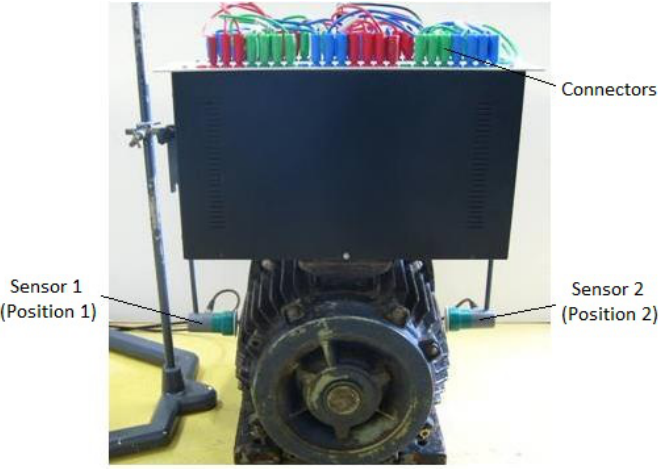
Figure 7. Salient synchronous modified machine and the sensors’ positions.